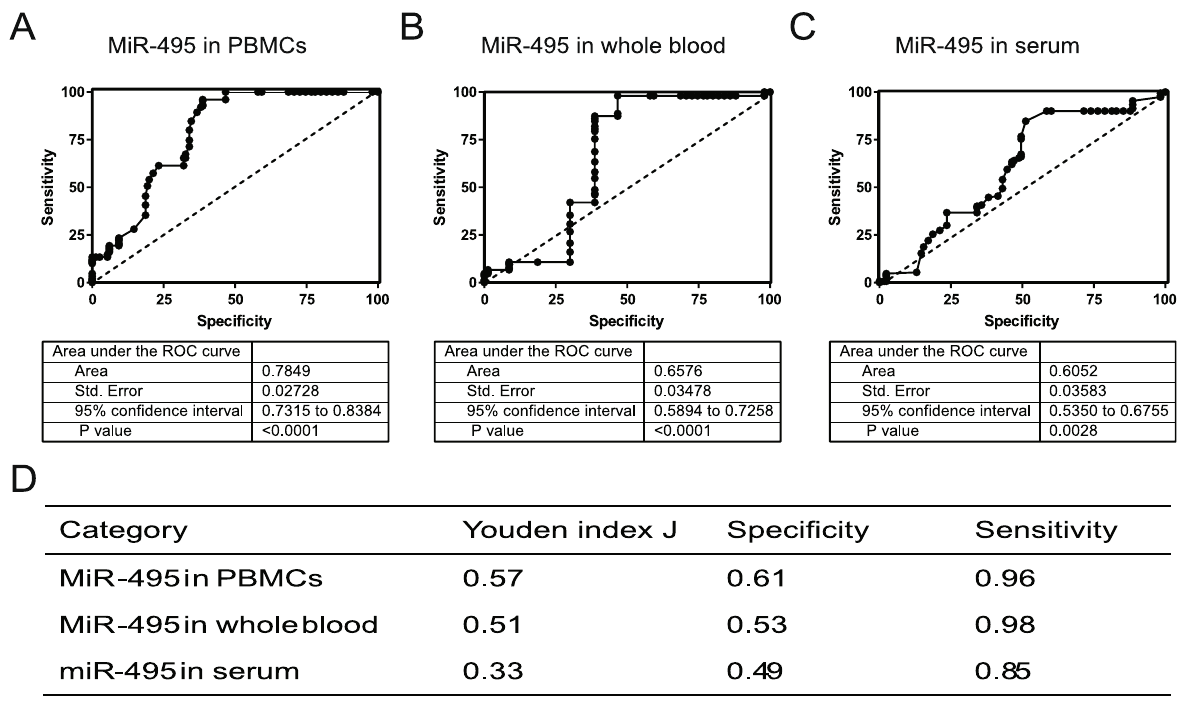
Fig. 5 ROC curves of miR-495 . a ROC curve of PBMC miR-495 . b ROC curve of whole blood miR-495 . c ROC curve of serum miR-495 . d Summary of miR-495 specificity and sensitivity. Youden index was used to evaluate the tested methods. And the Jordan index = sensitivity + specificity-1. When the maximum value of the Jordan index was determined, the corresponding specificity and sensitivity rates of ROC curve were also achieved. PBMCs: peripheral blood mononuclear cells; ROC: receiver operating characteristic. Area, Std. Error, 95% confidence interval, P value, Jordan index, specificity, and sensitivity were indicated as